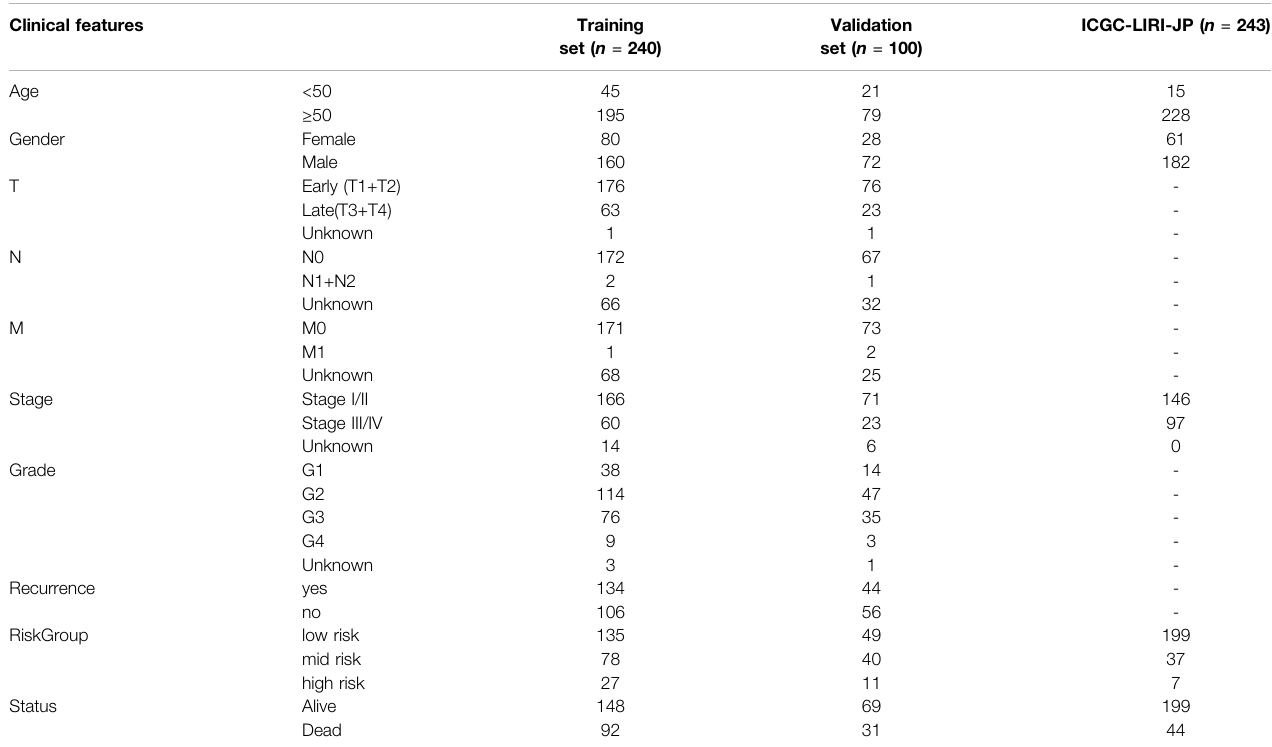
TABLE 1 | Clinical characteristics of HCC